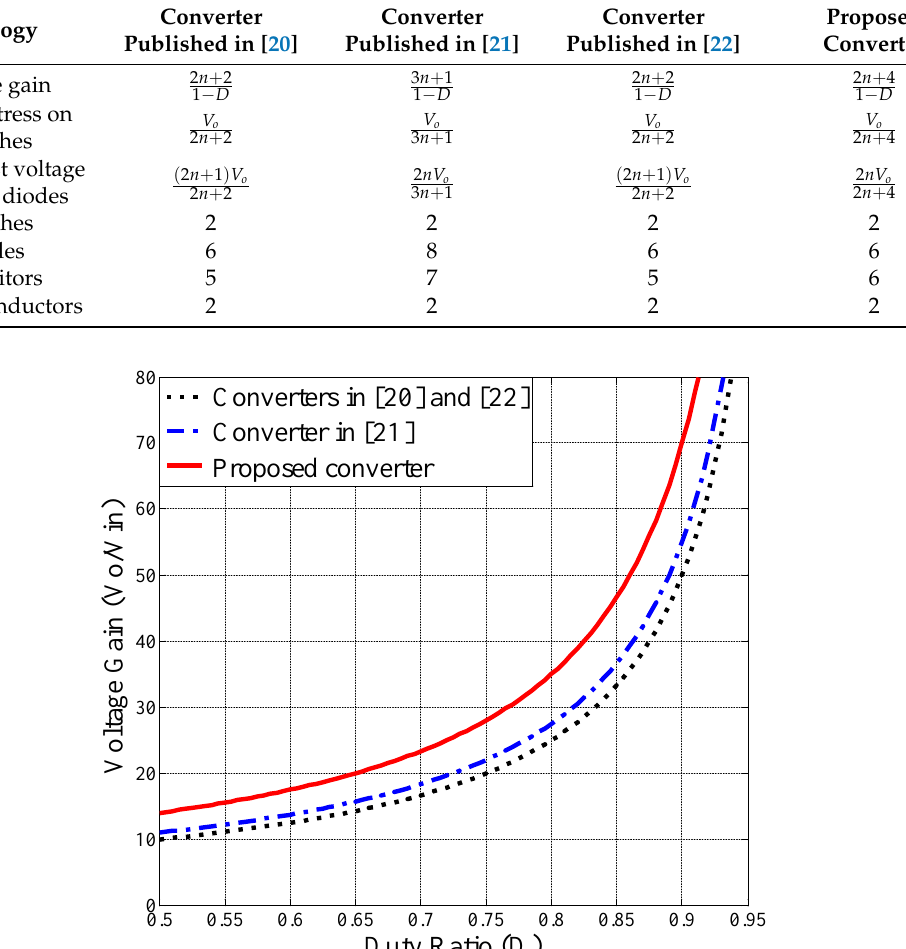
Table 2. Components and parameters of the prototype.